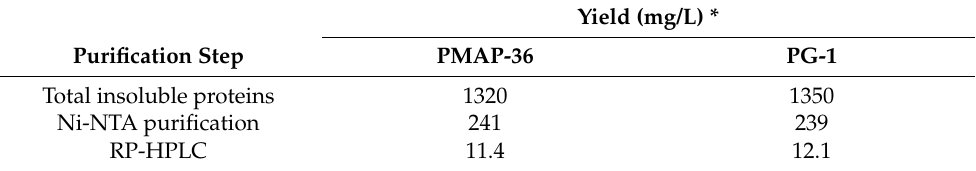
Table 1. Yield of recombinant PMAP-36 and PG-1 at various steps of purification.